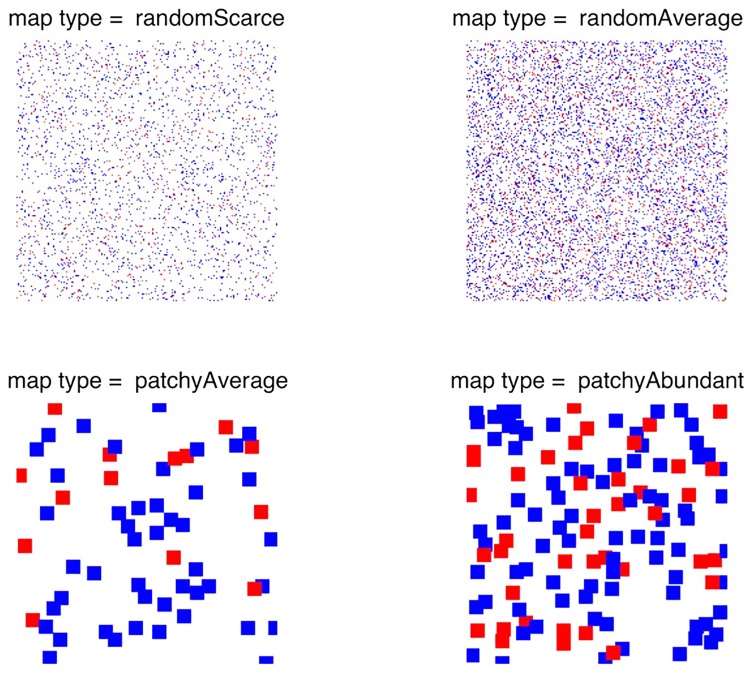
The simulations in experiment 6 were conducted for each of the four types of food distribution shown above, with blue representing poison and red representing food resources.